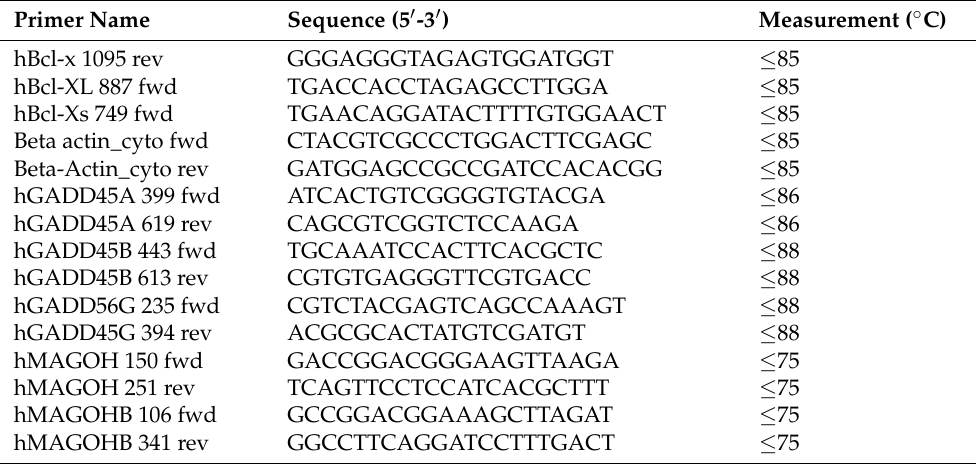
Table 3. QRT-PCR primer sequences and temperatures for